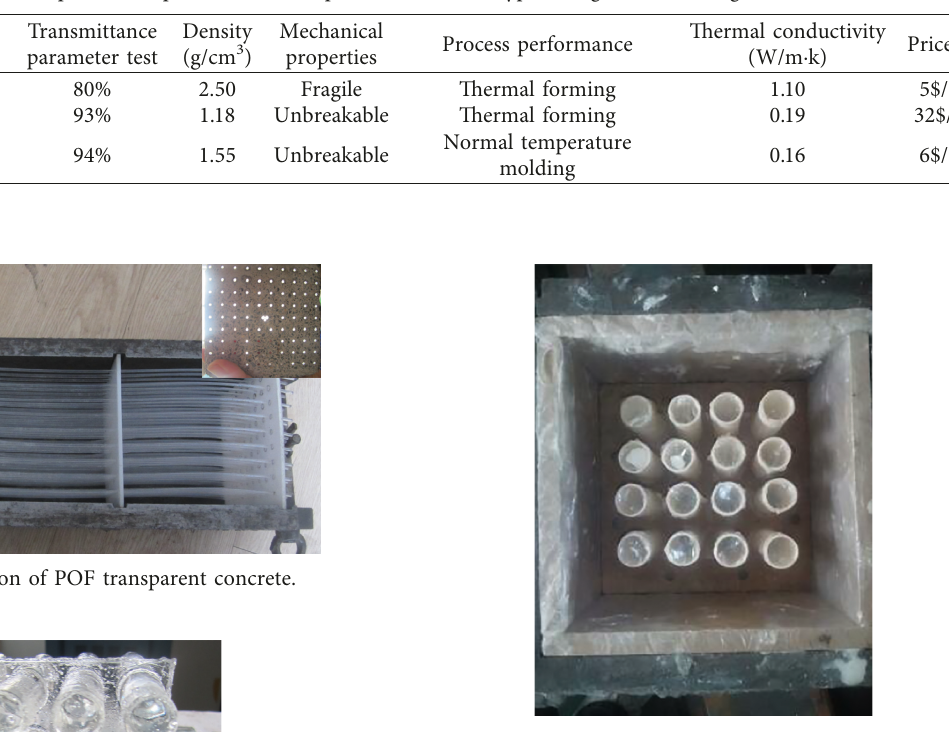
Table 2: Comprehensive performance comparison of various types of light-transmitting materials.